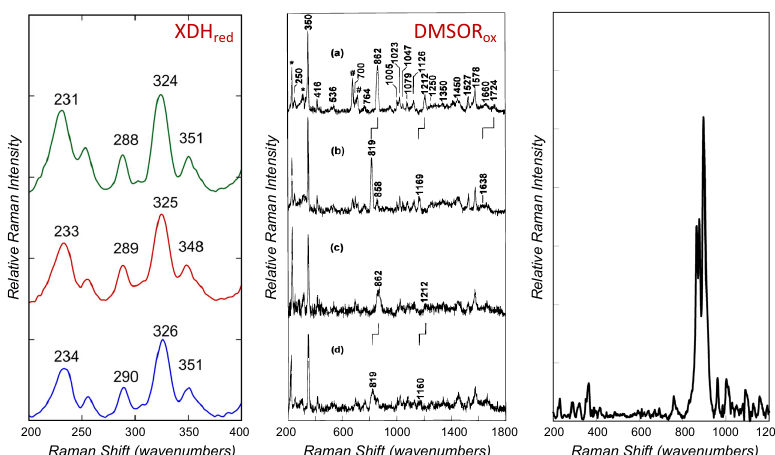
Figure 6. Resonance Raman spectra of xanthine dehydrogenase, sulfite oxidase and DMSO reductase. Left : Low-frequency resonance Raman spectra of Mo(IV)-product complexes formed from wt-XDH and specific variants using 4-thiolumazine as the substrate (green, Q197A; red, Q102G; blue, wt ) [12]. Data were collected on resonance with the Mo(IV) − P MLCT band. Middle : R. sphaeroides DMSO reductase resonance Raman spectrum. (a) Dithionite-reduced enzyme re-oxidized with 16 O DMSO; (b) dithionite-reduced enzyme reoxidized with 18 O DMSO; (c) as prepared enzyme; (d) enzyme that was exchanged into 18 O H 2 O buffer then dithionite-reduced and ferricyanide-oxidized. Lattice modes of ice (*), residual DMSO (#) Adapted with permission from [116]. Right : Resonance Raman spectrum of as-prepared plant SO from A. thaliana . Adapted with permission from